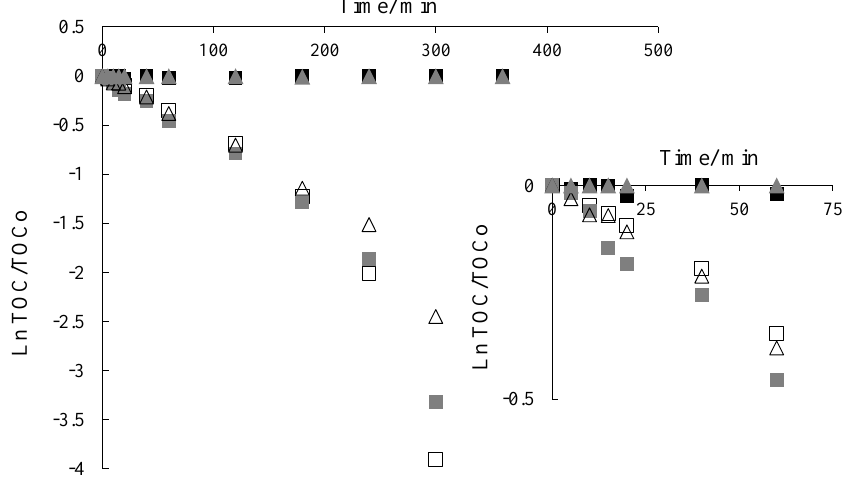
Figure 5. TOC removal in the semi-log scale during the electrolysis ( (cid:3) ), sonoelectrolysis at 20 kHz ( (cid:4) ), sonoelectrolysis at 10 MHz ( ∆ ) and sonolysis at 20 kHz ( (cid:4) ) sonolysis at 10 MHz ( (cid:78) ) of AMX and AMP solutions carried out in sulphate media (square symbols, 3 g L − 1 of Na 2 SO 4 ). Initial concentration: